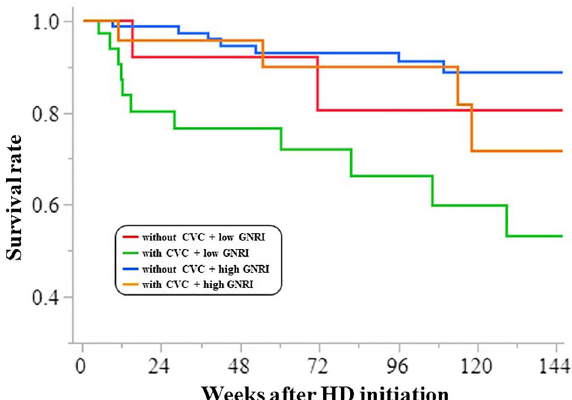
Figure 2. The 3-year survival rates after HD initiation. We compared four groups based on two parameters: with CVC + low GNRI score, without CVC + low GNRI score, without CVC + high GNRI score, and with CVC + high GNRI score. Those who belonged to the group “with CVC + low GNRI” had the lowest survival rate (46.5%, p < 0.0001) compared to the other groups (80.9%, 88.9%, and 71.6%, respectively). CVC, central venous catheter; GNRI, geriatric nutritional risk index; HD, hemodialysis.